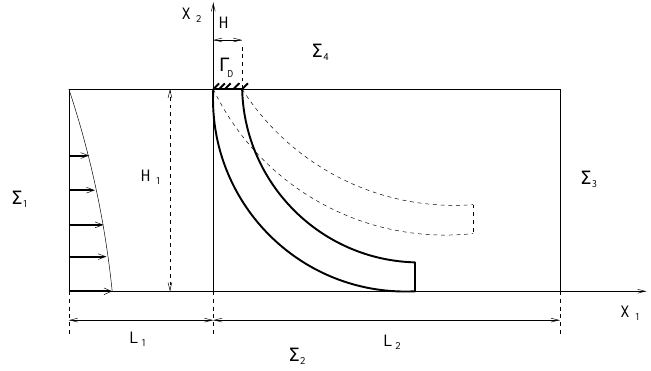
Figure 5. The geometrical configuration of